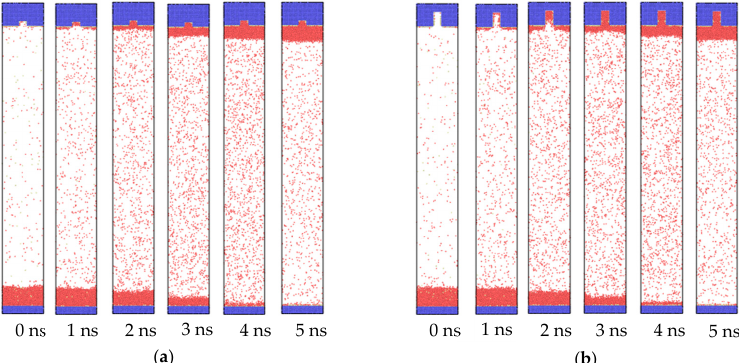
Figure 2. Snapshots of the atoms’ trajectories for nanostructures with a groove width of 1.8 nm and height of ( a ) 0.8 nm and ( b ) 2.8 nm on hydrophilic